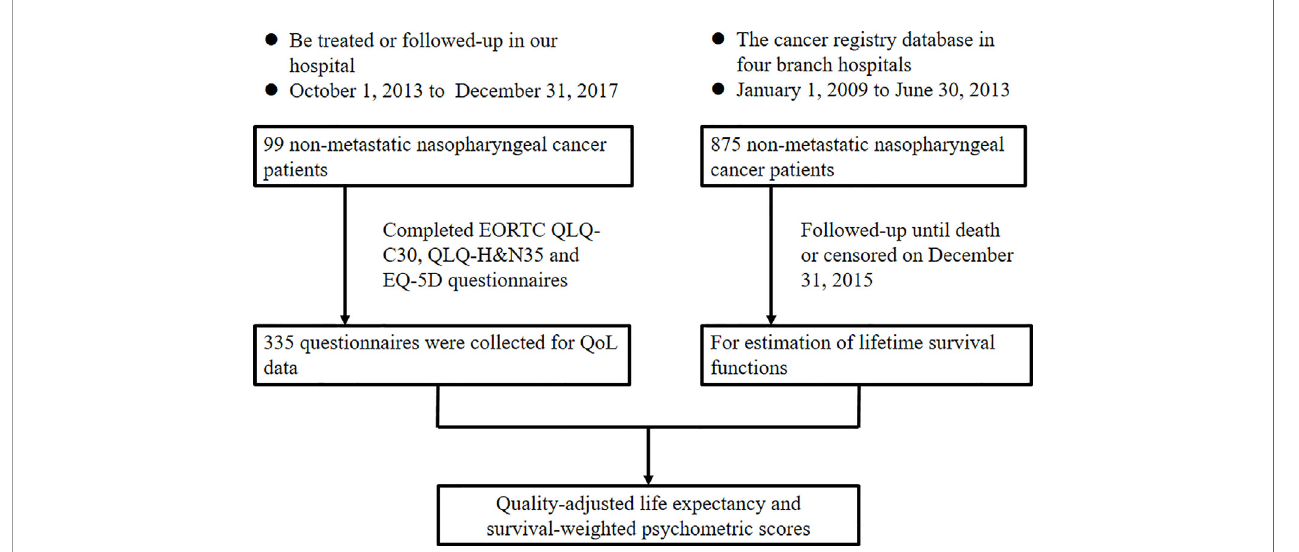
FIGURE 1 | Flowchart of the study design. EORTC, European Organization for Research and Treatment of Cancer; QLQ, quality of life questionnaire; H&N, head and neck; EQ-5D, EuroQol- 5 Dimension; QoL, quality of